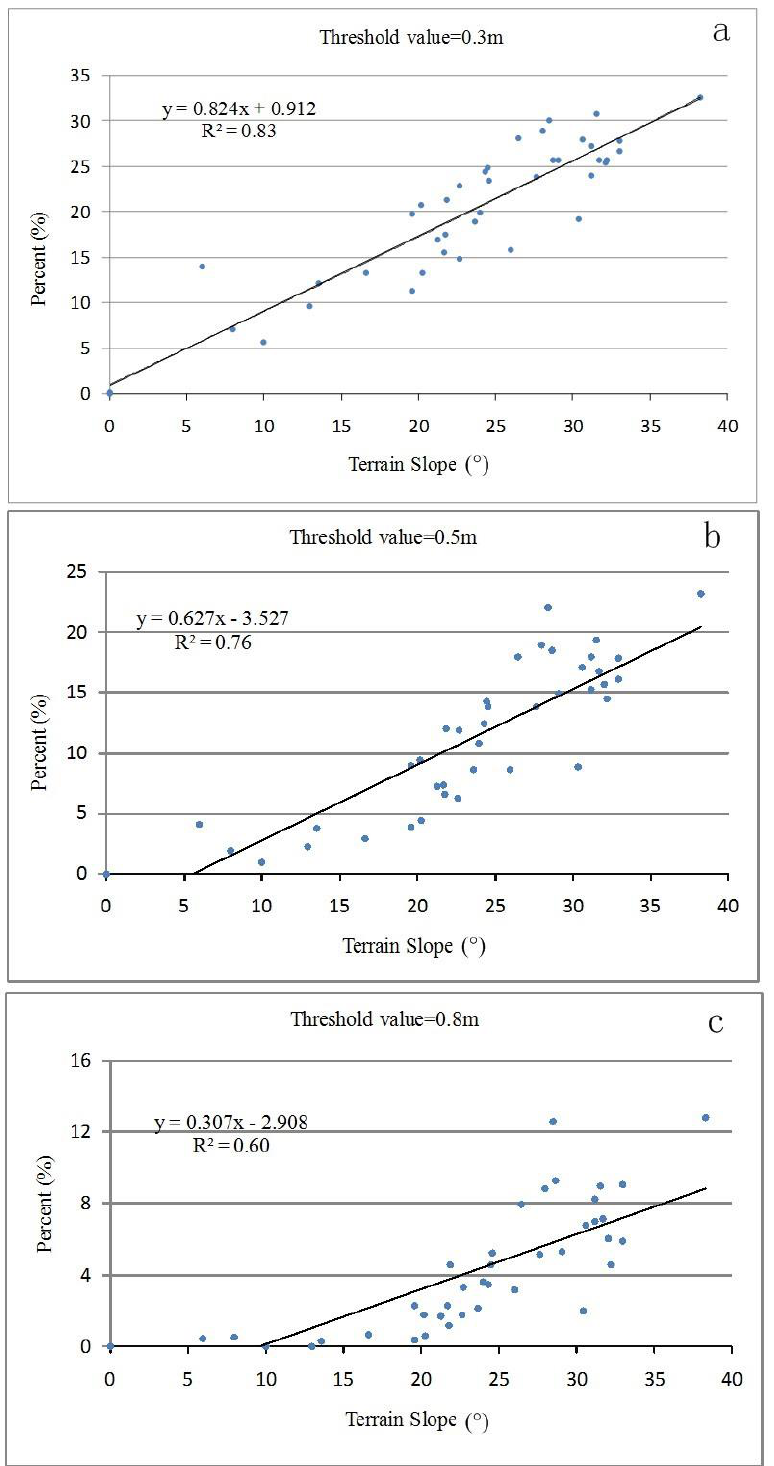
Figure 12. Regression relationships between slope and proportions of points with differences greater than selected thresholds: ( a ) threshold = 0.3 m; ( b ) threshold = 0.5 m; ( c ) threshold = 0.8